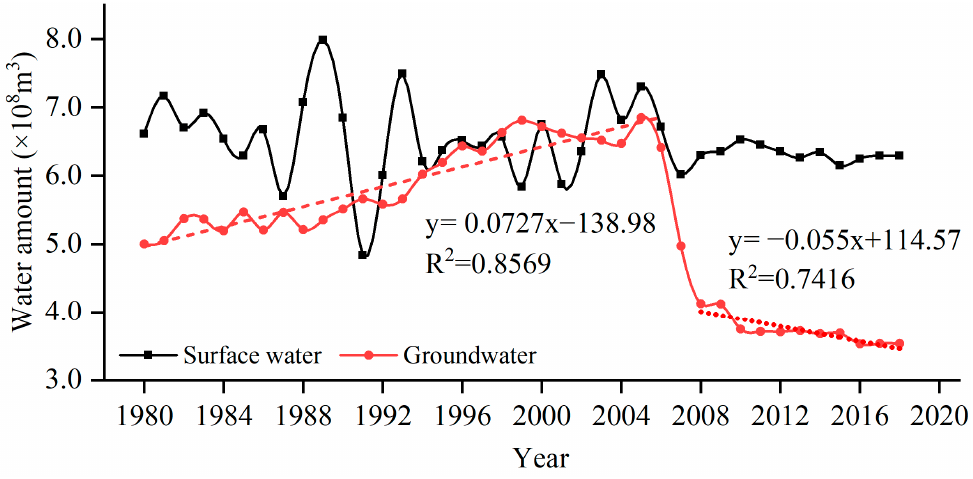
Figure 9. Amount of surface water conveyance and groundwater extraction since 1980.